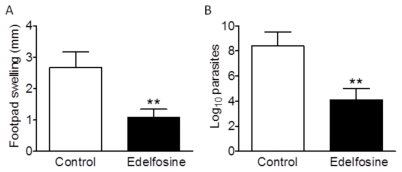

In vivo antileishmanial action of edelfosine in L. major-infected mice.BALB/c mice were infected with 2×106
L. major promastigotes in the left hind footpad, and after swelling was perceptible, mice were randomized into drug-treated (15 mg edelfosine/kg of body weight, daily oral administration for 28 days) and control (water vehicle) groups of 7 mice each. After completion of the 4-week treatment, lesions were evaluated by measuring the footpad swelling (A) and determining the parasite load (B), using caliper measurements and limiting dilution assays respectively. Data are means ± SD (n = 7). Asterisks indicate that the differences between control and edelfosine-treated groups are statistically significant. (**) P<0.01.